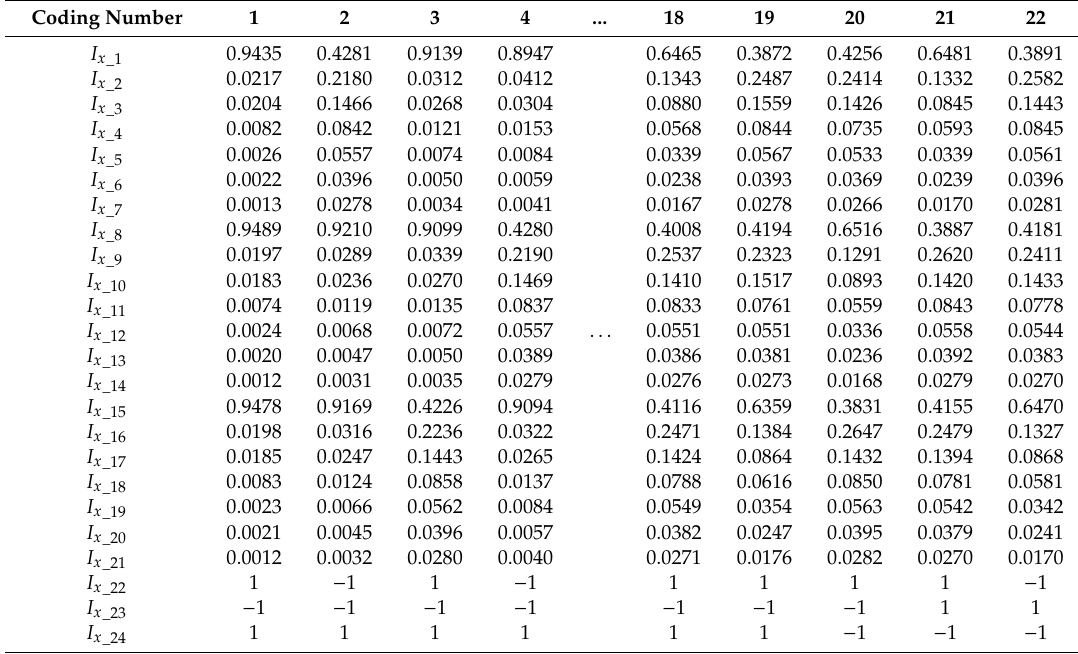
Table 3. The trend feature vectors under 22 states of